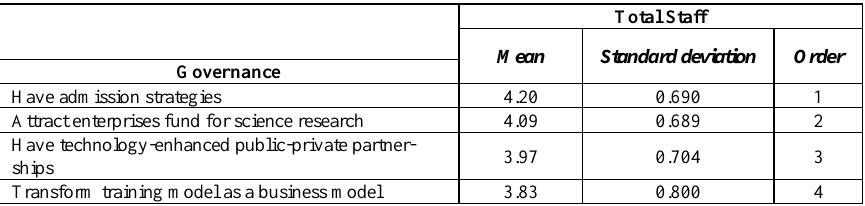
Table 5. Opinions about readiness in governance for HUST